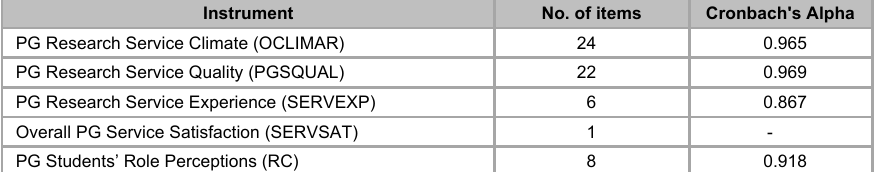
Cronbach’s coefficient alpha values of constructs used in the